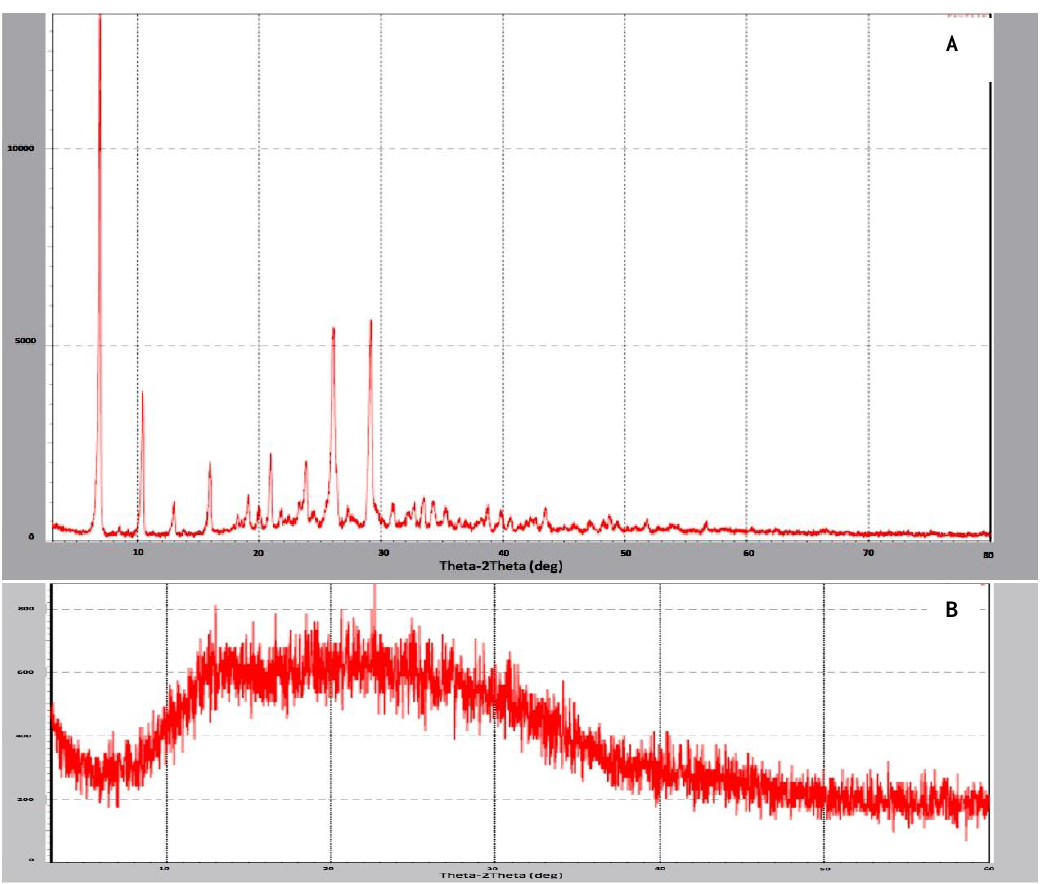
Figure 4. a. XRD of pure ACV [A]eudragit RS100